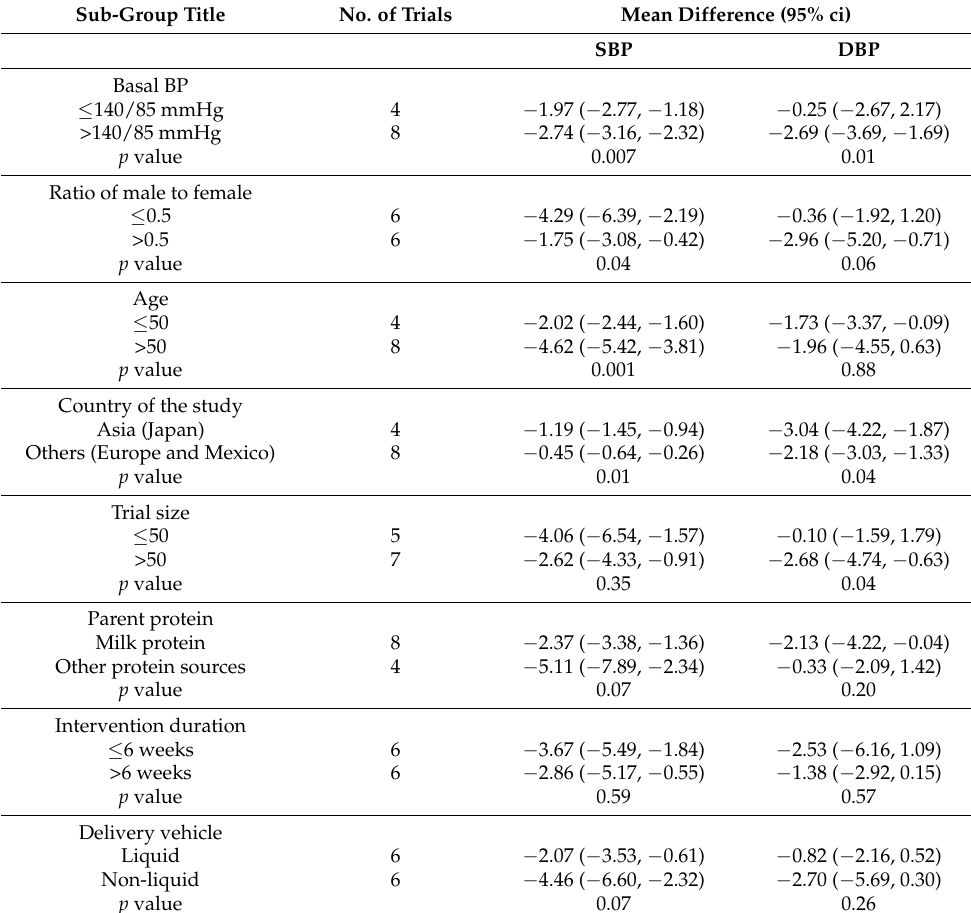
Table 2. Sub-group analyses of the included trials.